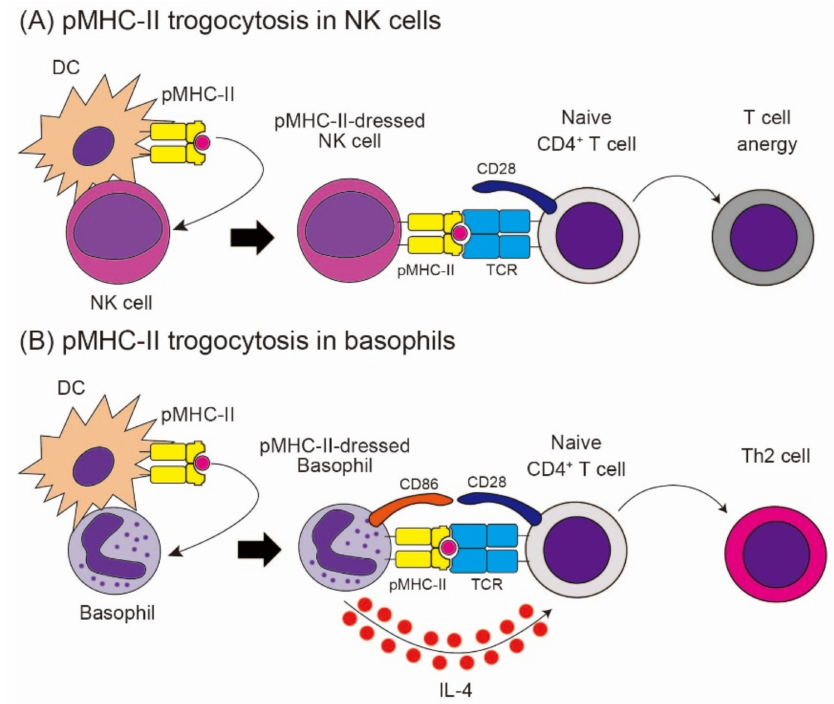
Figure 6. The trogocytosis of pMHC-II in NK cells and basophils. ( A ) NK cells acquire pMHC-II from APCs via trogocytosis. pMHC-II-dressed NK cells rather suppress CD4 + T cell responses, possible because of their low expression of co-stimulatory molecules. ( B ) Basophils acquire pMHC-II from APCs via trogocytosis. pMHC-II-dressed basophils present antigens to naïve CD4 + T cells, leading to T cell proliferation and differentiation into Th2 cells with the aid of the IL-4 produced by basophils. Basophils are the least common granulocytes, which represent less than 1% of periph- eral blood leukocytes. The functional significance of basophils has long been an enigma, partly because of their rarity and the paucity of analytical tools for basophil